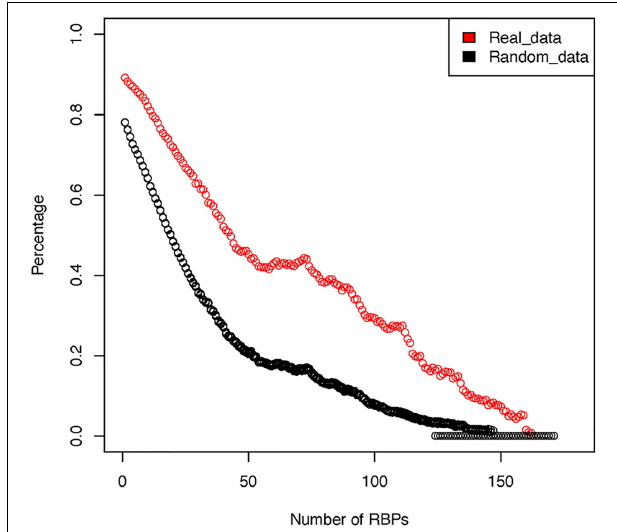
FIGURE 3 | Overlap among RBP binding sites after sequentially removing RBPs with the highest number of binding sites. The red circles represent real observed data while the black circles represent averaged results over 10 rounds of random